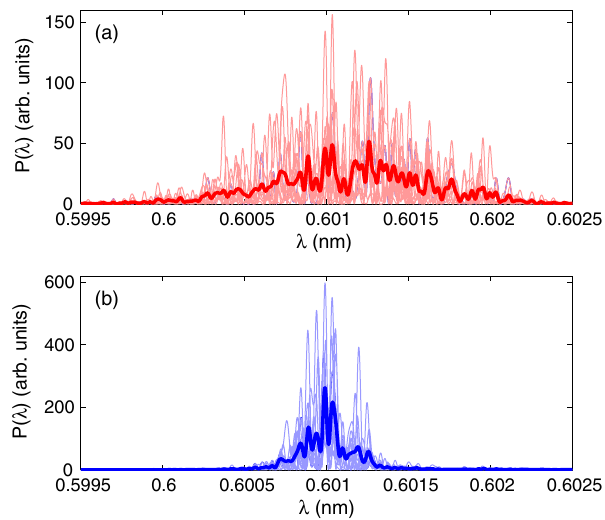
FIG. 7. Spectrum of the FEL radiation produced in the stan- dard SASE (a) and the pSASE mode (b). Thin lines refer to single shot realizations and the bold line refers to the average over ten realizations.